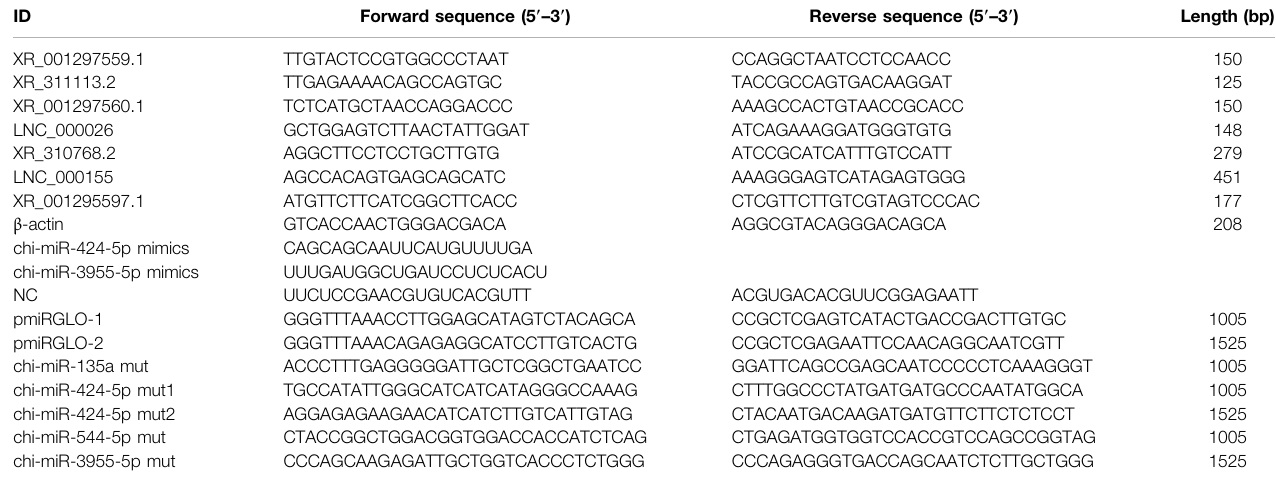
TABLE 1 | The nucleotide sequence used in this